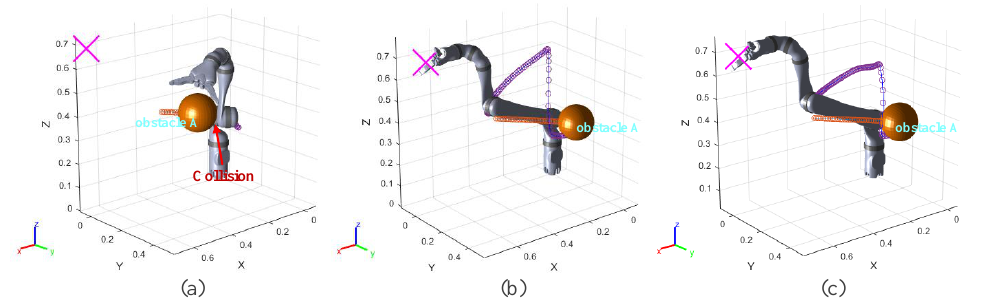
Figure 9. Experiments C: the running process of the robot arm when it is using three algorithms.